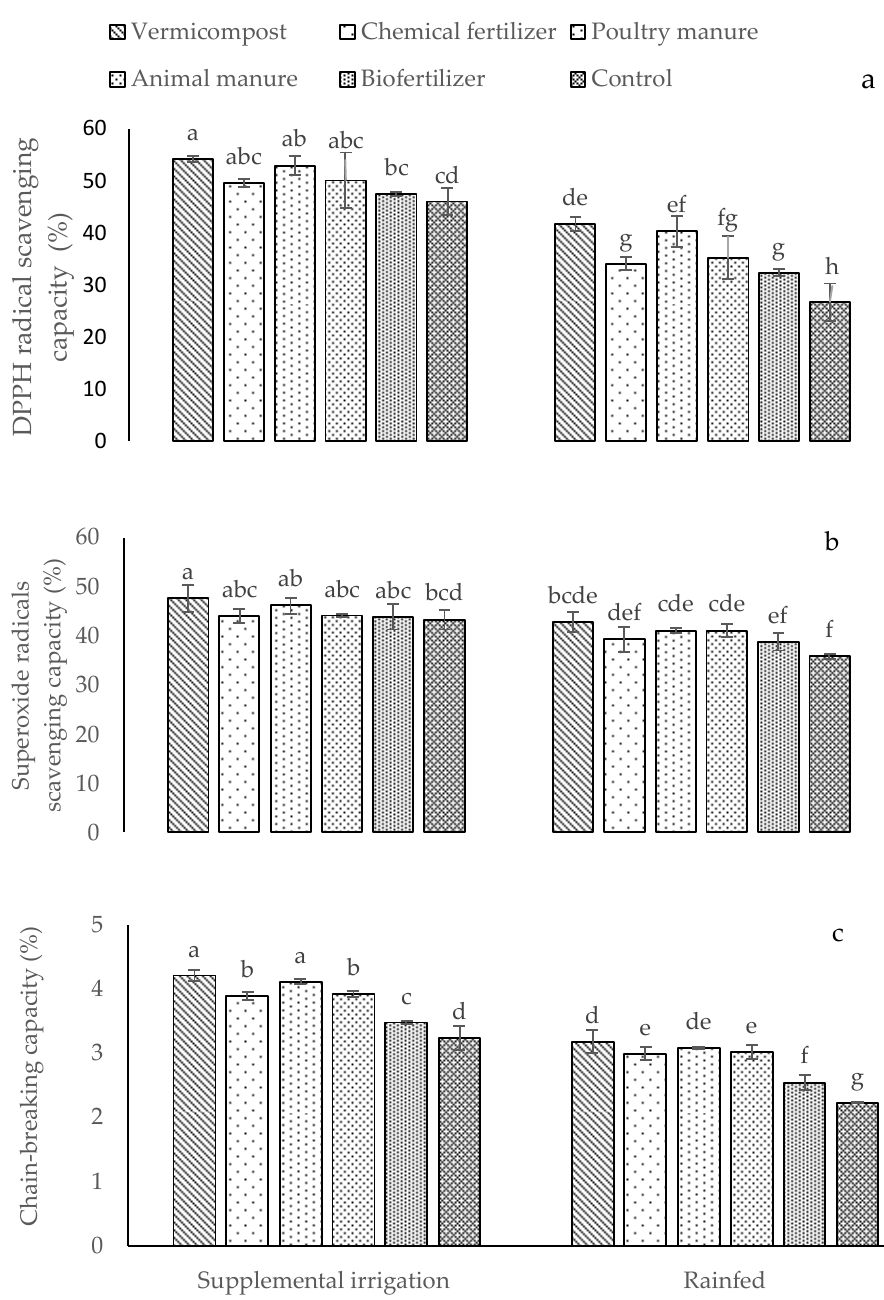
Figure 5. Means ( ± Standard deviation, SD) comparison for the interaction impacts of fertilizer and irrigation conditions on DPPH radical scavenging capacity ( a ), superoxide radical scavenging capacity ( b ), and chain-breaking capacity ( c ). DW: dry weight. The means with different letters differ significantly at p ≤ 0.05 based on Tukey’s HSD test.